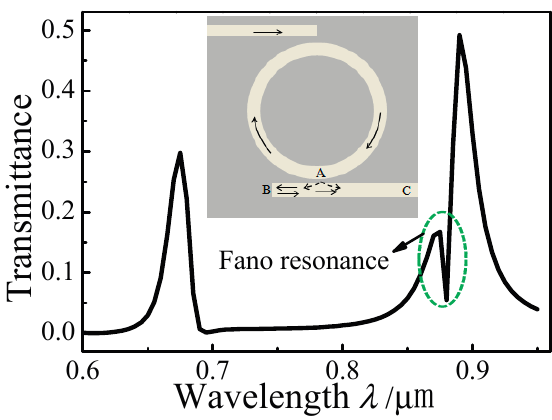
Figure 6. Transmission spectrum and SPP propagation path (inset) in a schematic of the MIM waveguide-coupled ring resonator.